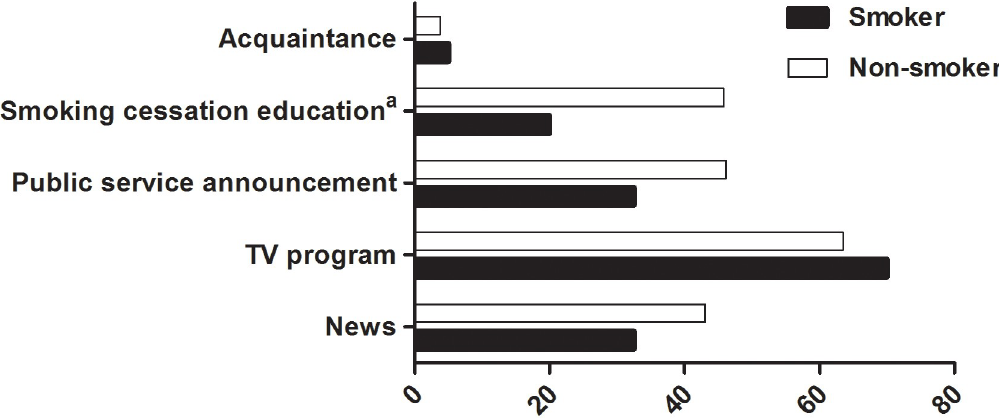
Fig 1. Sources of secondhand smoke-related knowledge. Data expressed as percent. a p = 0.002 between smokers and non-